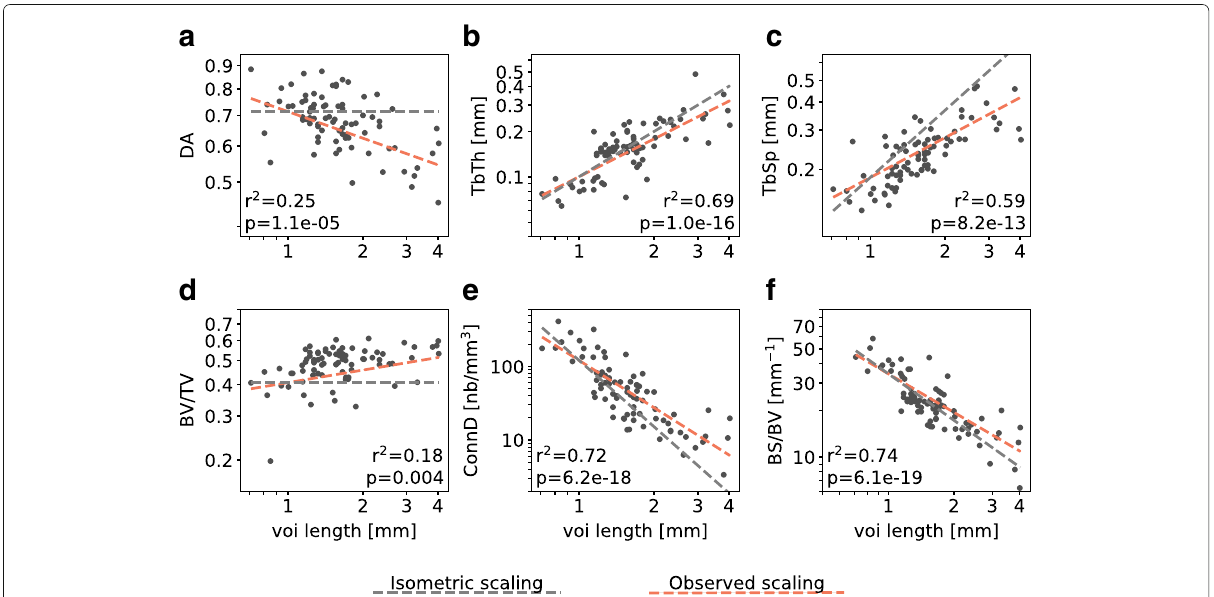
Fig. 4 Allometric scaling in trabecular parameters. Each plot shows the relation between the trabecular parameter and edge length of the cubic VOI ( vl ), the latter serving as proxy for body mass (see text). Raw data were plotted on log-log scale. r 2 - coefficient of determination, p - p -value of the regression. a-c Degree of anisotropy DA , trabecular thickness TbTh and trabecular separation TbSp scale with negative allometry. d-f Bone volume fraction BV/TV , connectivity density ConnD and bone surface density BS/BV scale with positive allometry